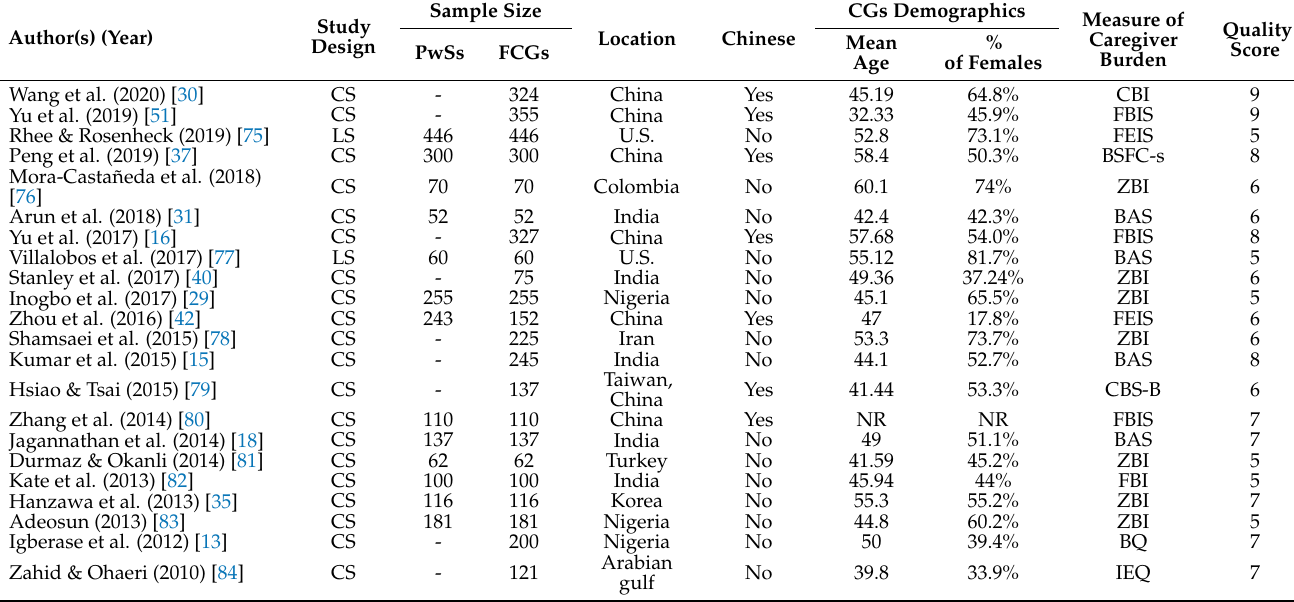
Table 1. Characteristics of the included studies ( n =